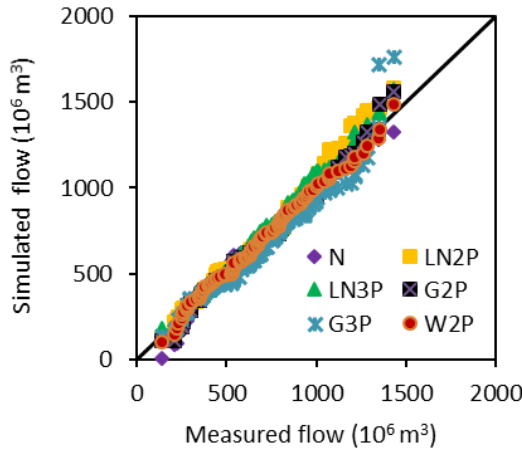
Figure 5. Q–Q plot of the selected probability density functions (N = normal, LN2P = two-parameter log-normal, LN3P = three- parameter log-normal, G2P = two-parameter gamma, G3P = three- parameter gamma and W2P = two-parameter